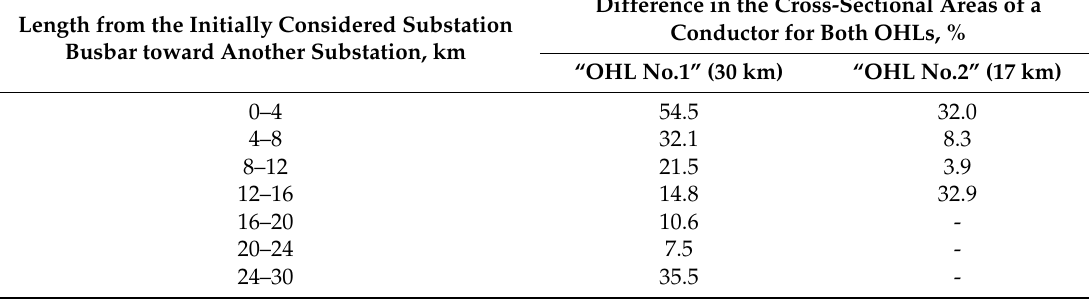
Table 5. Comparison between selected cross-sectional areas of conductor for both OHLs. Difference in the Cross-Sectional Areas of a Length from the Initially Considered Substation Conductor for Both OHLs, Busbar toward Another Substation, km